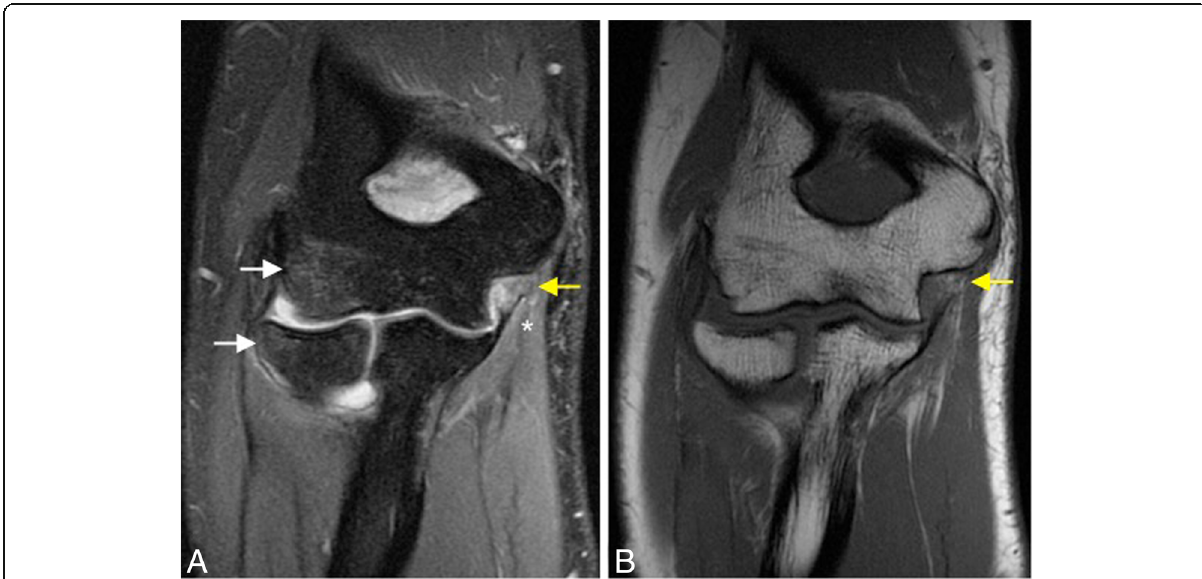
Fig. 14 A 23-year-old man with pain and medial instability after a fall on the outstretched arm. Coronal FS PD-weighted MRI ( a ) and coronal T1- weighted MRI ( b ) showing an acute full-thickness proximal tear of the anterior bundle of the medial collateral ligament complex (yellow arrows),